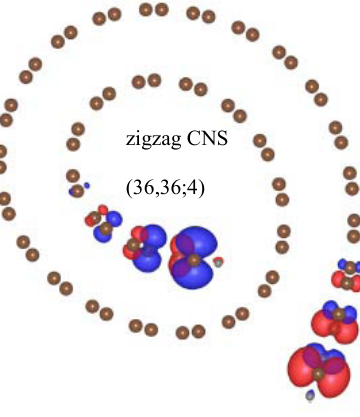
Figure 5. The charge distribution of spin-up and spin-down states, indicated by red and blue regions,